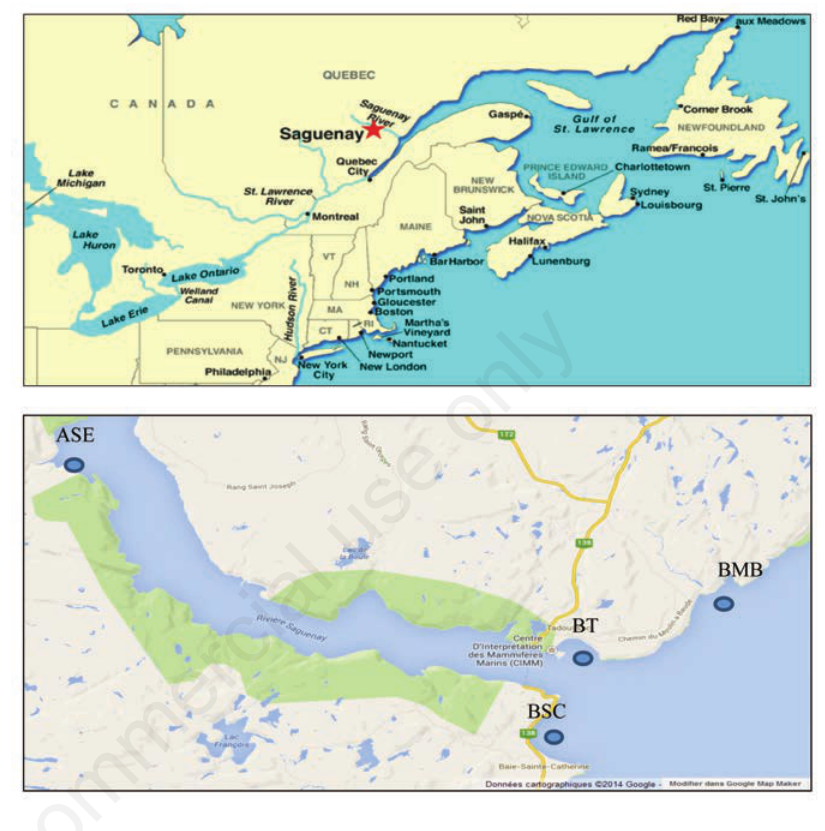
Figure 1. Map of the study area showing the 4 sites where bivalves were sampled. BT, Baie de Tadoussac; BSC, Baie Sainte-Catherine; BMB, Baie du Moulin-à-Baude; ASE, Anse Saint-Étienne.